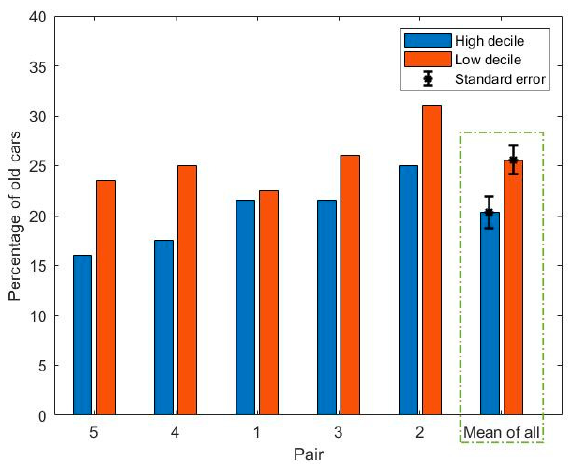
Figure 5. Bar plot of the percentage of old cars (manufactured before 2005) for the roads along each of the school routes.